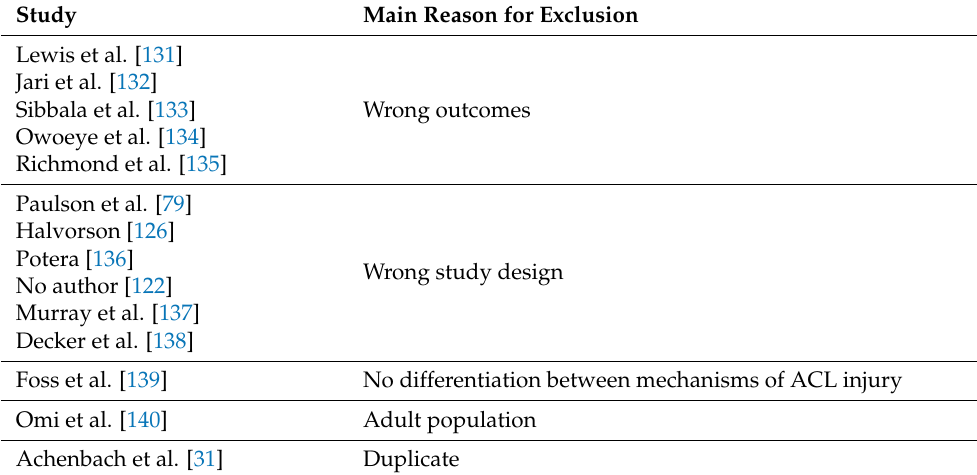
Table A2. The reasons for the exclusion of all studies that were excluded after a full-text review of primary literature are listed